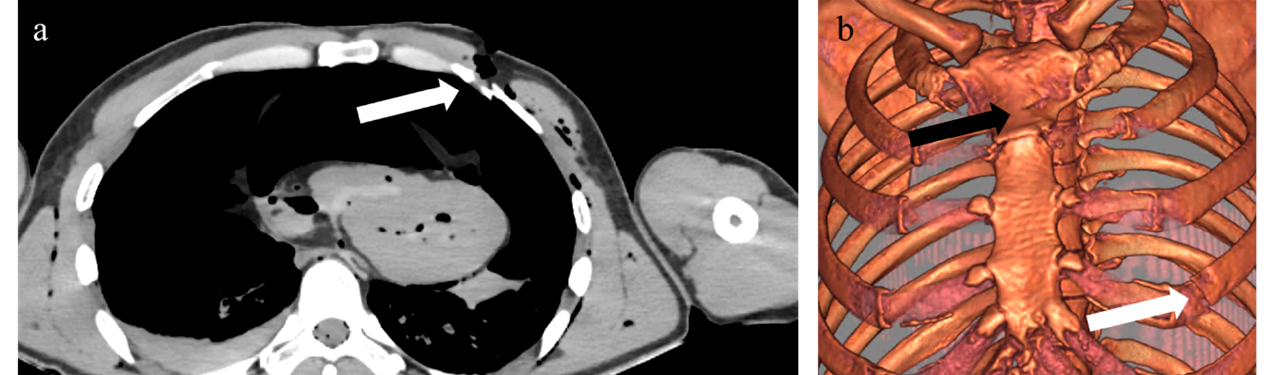
Figure 2. Two-dimensional ( a ) and three-dimensional ( b ) view of a sharp force homicide postmortem CT. White arrows indicate the same lesion on the left fourth rib and a sternal lesion (black arrow).